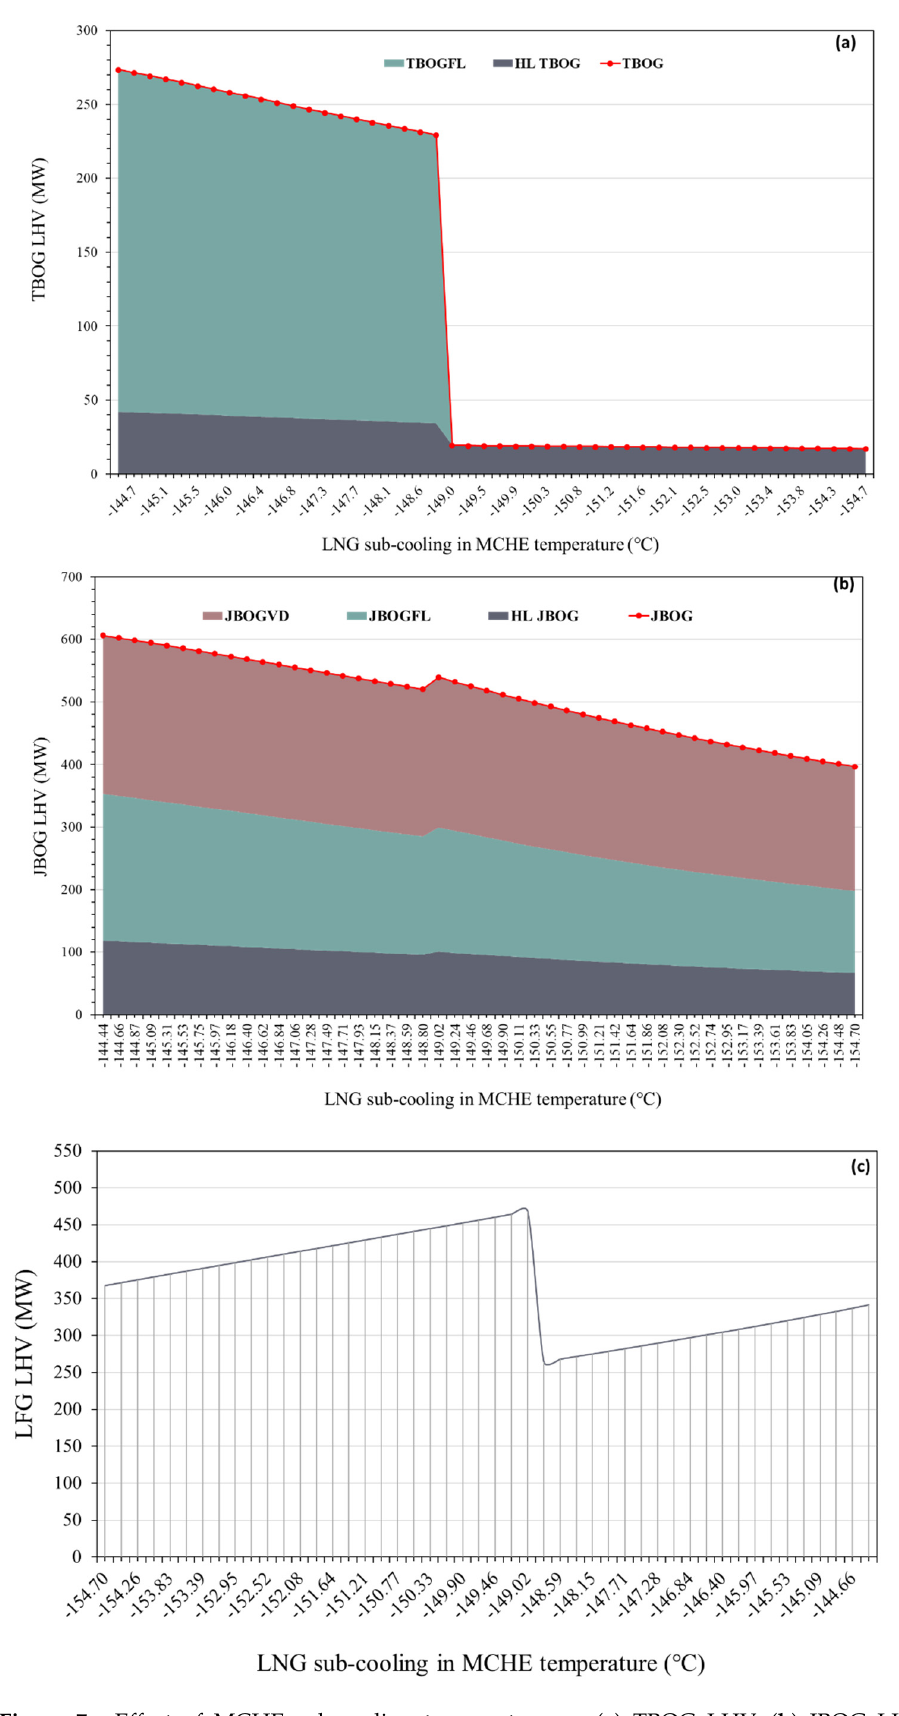
Figure 7. Effect of MCHE sub-cooling temperature on ( a ) TBOG LHV, ( b ) JBOG LHV, and ( c ) LFG